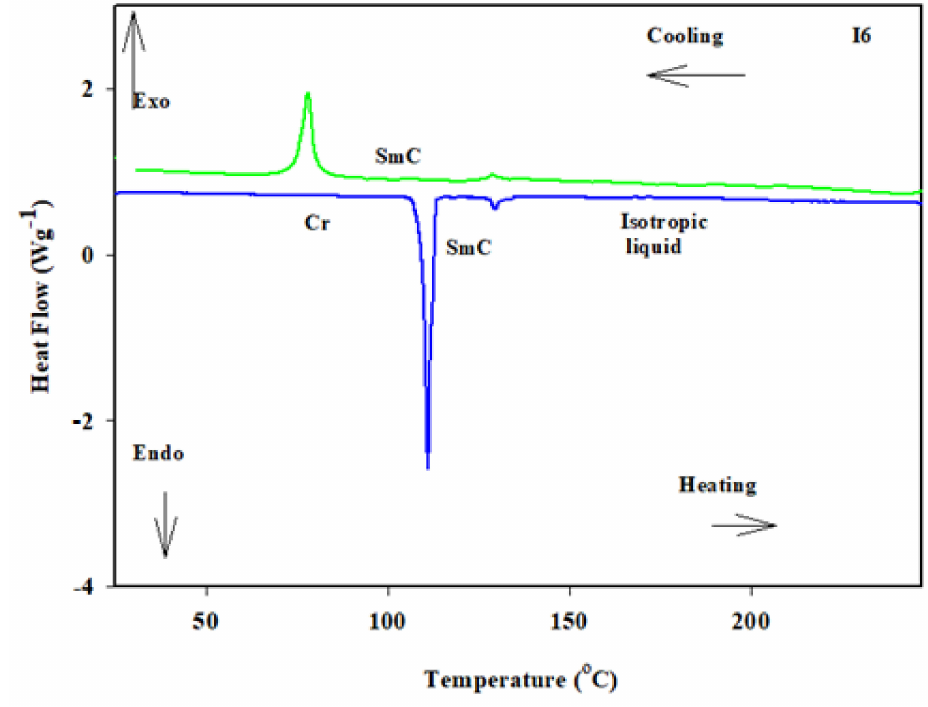
Figure 1. DSC curve of derivative I6 upon heating/cooling rounds with heating rate 10 ◦